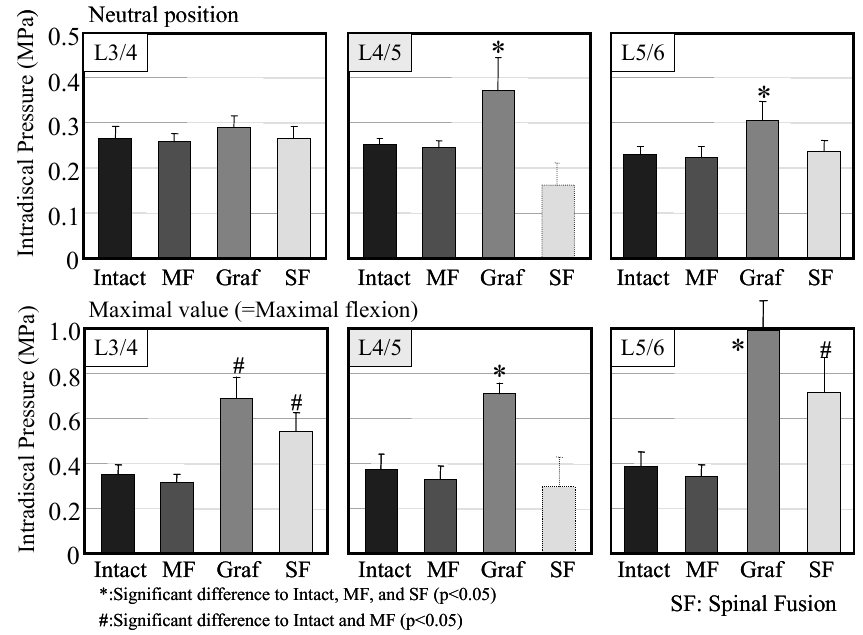
Fig. 6 Data on the intradiscal pressure for each instrumented model. With the Graf system, the intradiscal pressure in the neutral position was increased significantly. The maximum intradiscal pressure was measured at the position of maximum flexion. The maximum intradiscal pressure increased significantly at L3/4 to L5/6, respectively, with the Graf system. With spinal fusion, the maximum intradiscal pressure increased significantly at L3/4 and at